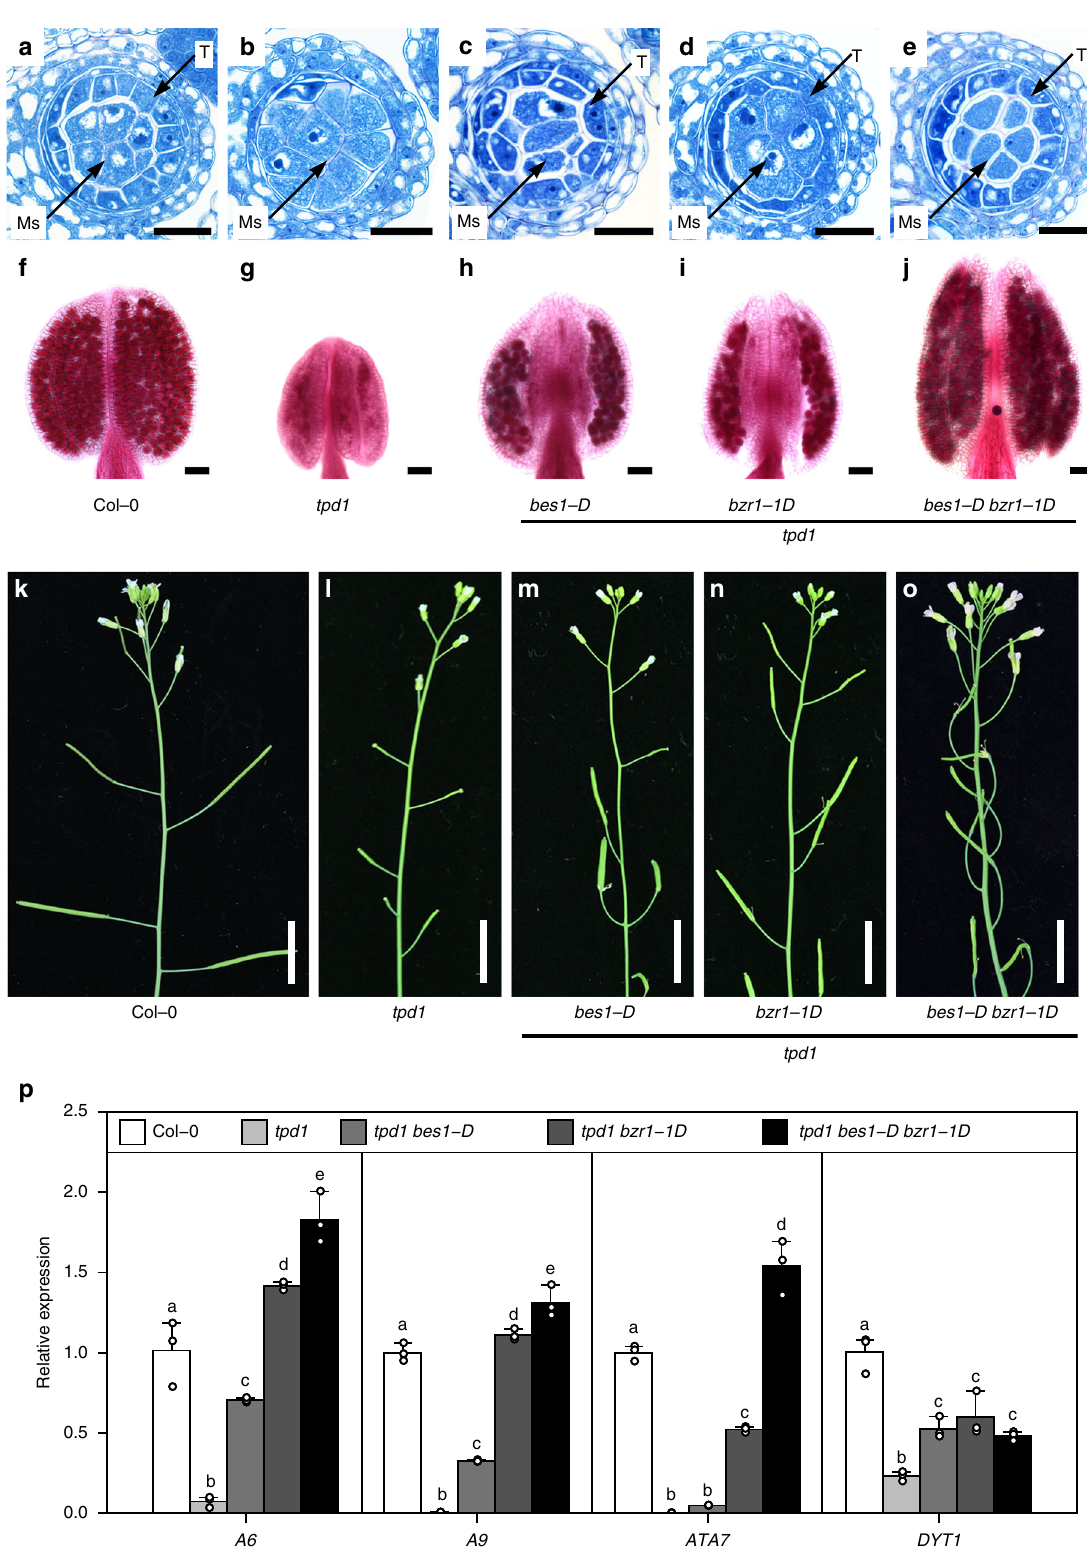
Fig. 6 bes1-D and bzr1-1D can partially suppress anther developmental defects and male sterility of tpd1 . a – e Toluidine blue stained anther semithin sections of Col-0 ( a ), tpd1 ( b ), tpd1 bes1-D ( c ), tpd1 bzr1-1D ( d ), and tpd1 bes1-D bzr1-1D ( e ). f – j Alexander stained anthers of Col-0 ( f ), tpd1 ( g ), tpd1 bes1-D ( h ), tpd1 bzr1-1D ( i ), and tpd1 bes1-D bzr1-1D ( j ). k – o In fl orescences of Col-0 ( k ), tpd1 ( l ), tpd1 bes1-D ( m ), tpd1 bzr1-1D ( n ), and tpd1 bes1-D bzr1-1D ( o ). Tapetum layer (T), and microsporocytes (Ms) are indicated by arrows. p Quantitative RT-PCR analyses to show relative gene expression levels of tapetum marker genes, A6 , A9 , ATA7 , and DYT1 in the in fl orescences of Col-0, tpd1 , tpd1 bes1-D , tpd1 bzr1-1D , and tpd1 bes1-D bzr1-1D . Data are presented as mean and s.d. ( n = 3). Statistically signi fi cant differences between groups were tested using one-way ANOVA followed by LSD (least signi fi cant difference) post hoc test. Different letters indicate signi fi cant difference at P < 0.05. Scale bars represent 20 μ m in ( a – e ), 50 μ m in ( f – j ), and 1 cm in ( k – o